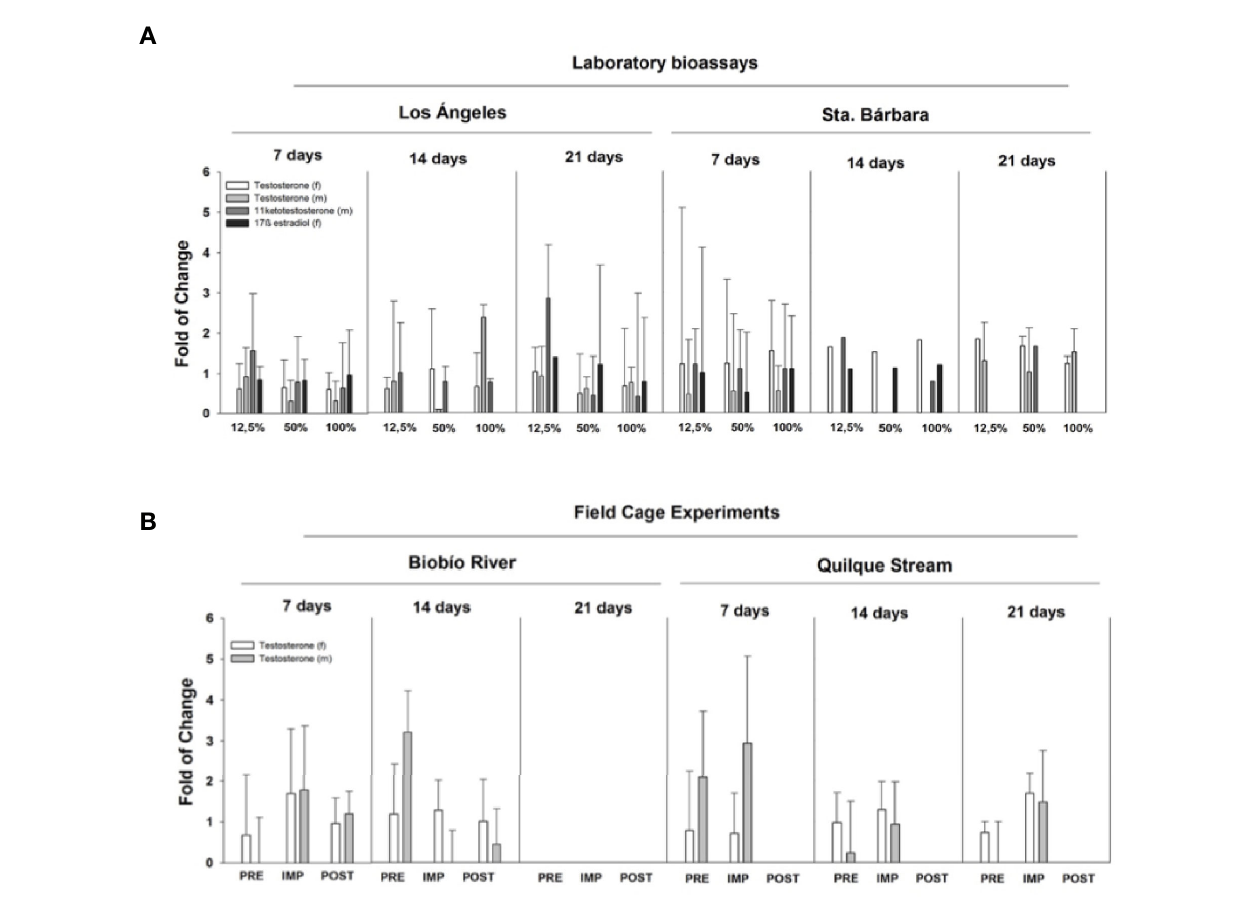
FIGURE 5 | Steroidal hormone levels in male (m) and female (f) rainbow trout exposed to WWTP ef fl uents in the Biob ı ́ o River basin. (A) Laboratory bioassays show responses in testosterone, 17 b -estradiol, and 11 ketostestosterone to 12.5%, 50%, and 100% ef fl uent exposure after 7, 14, and 21 days. (B) fi eld cage experiments are reported for PRE, pre-impact zone, IMP, impact zone, POST,: post-impact zone of Biobio river